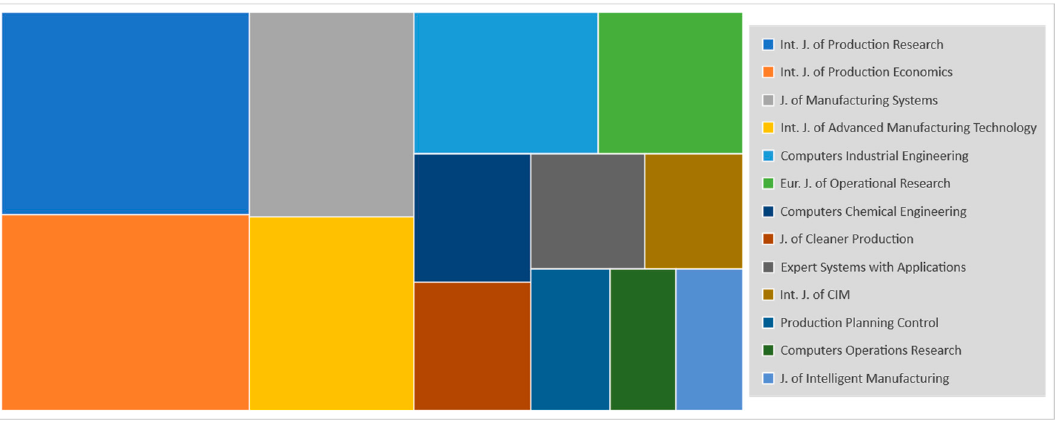
Figure 4. Distribution of in-plant supply optimization in manufacturing systems related articles in journals, based on a search in Web of Science.